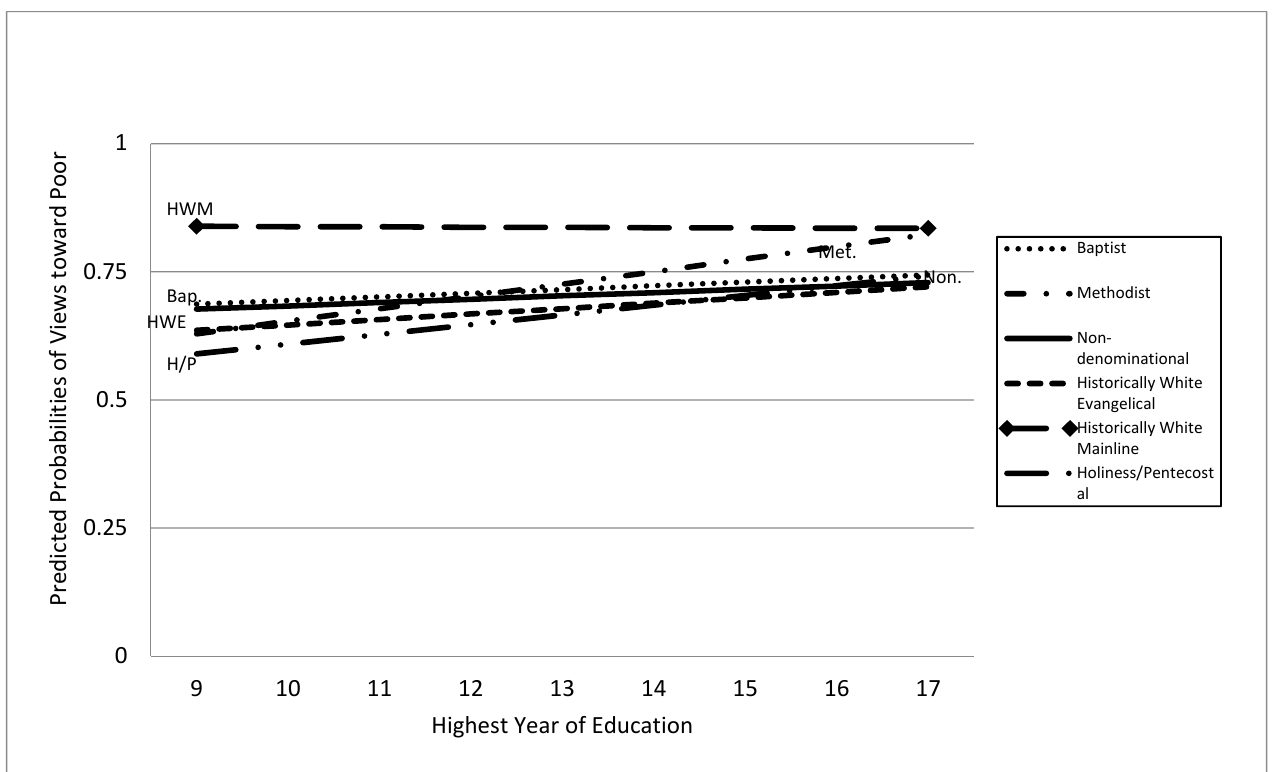
Figure A6. Black Protestant views toward the poor by religion and education, Pew 2014 Religious Landscape Survey.